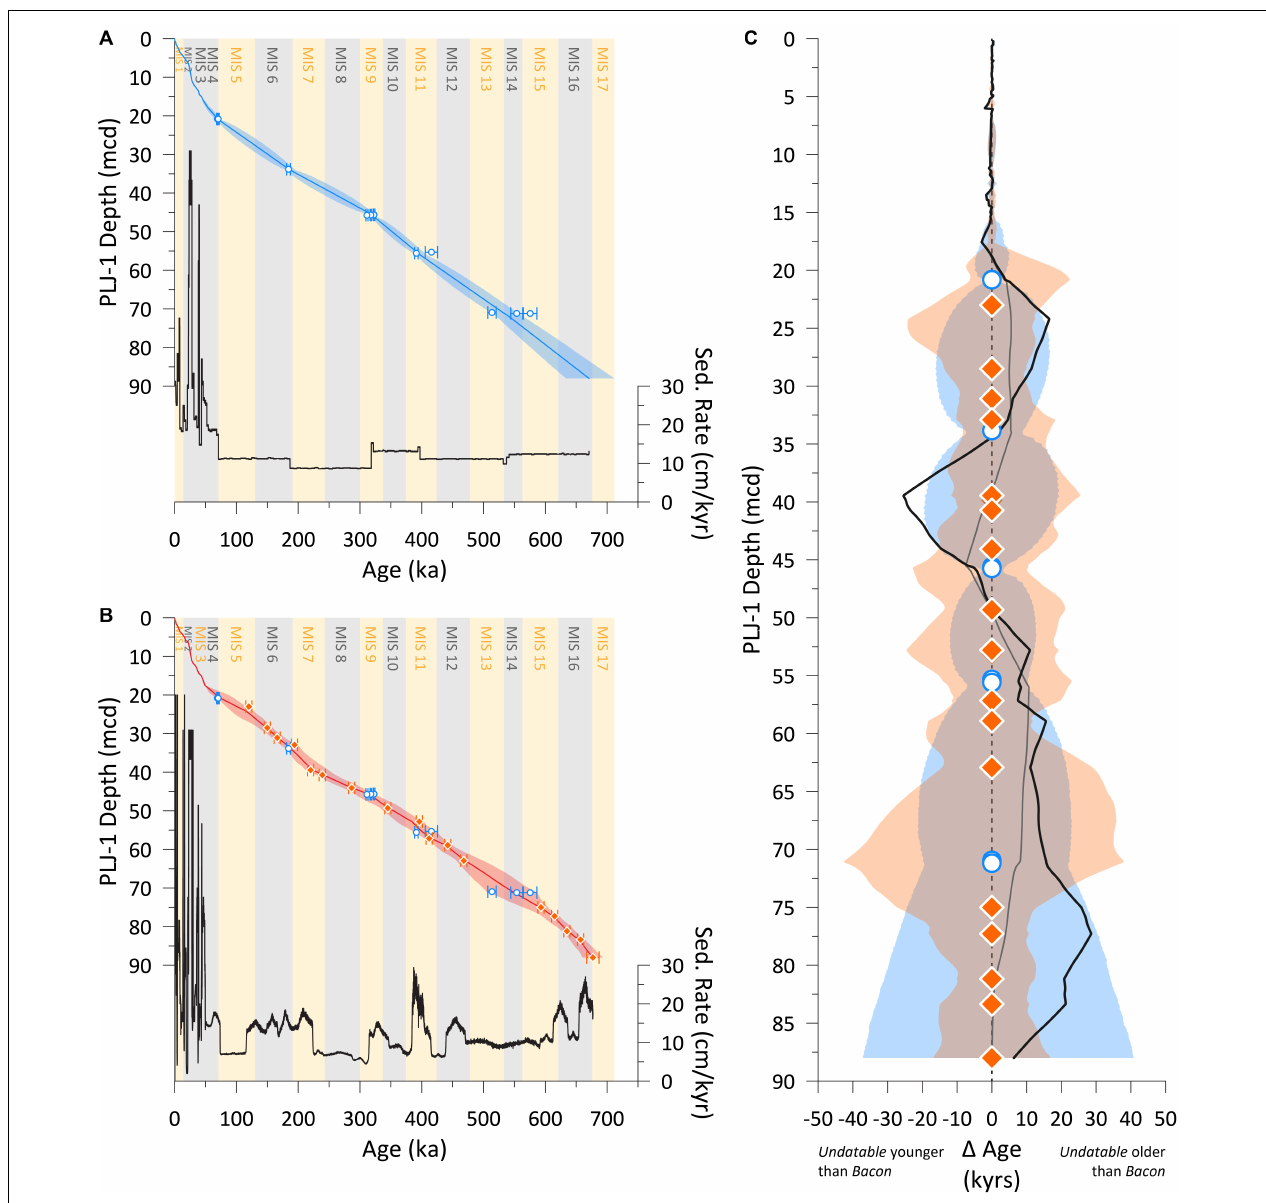
FIGURE 9 | (A) The existing Bacon age model (blue line) of Chen et al. (2020) reproduced from Figure 1 for comparison. (B) The new Undatable derived age-depth model (red line) using 79 radiocarbon dates (not shown for clarity) from Woods et al. (2019), 18 U-Th age constraints for the Lake Junín splice [blue symbols as in A ; (Chen et al., 2020)], and 17 paleomagnetic tie points (orange symbols) identified in Figure 8 . The 2-sigma uncertainty (red shading) and calculated mean sedimentation rate (black line) is also shown. Marine Isotope Stages (MIS) are denoted by gray shading for glaciations and yellow shading interglaciations as defined in LR04 (Lisiecki and Raymo, 2005). (C) The Bacon age-depth mean-age model is subtracted from the Undatable age-depth mean-age model (black line) and the radiometric only Undatable age-depth mean-age model (thinner gray line, see text for details). Positive [negative] values imply an older [younger] age of the Undatable age-depth models compared to the Bacon age-depth model. The depth of U-Th age constraints (open blue circles) and paleomagnetic tie-points (orange diamonds) are shown alongside the uncertainty envelope of the existing Bacon age-depth model (blue) and new Undatable age-depth model (orange). Note that the offset of the two age models mostly falls within the uncertainty envelope of both age models.